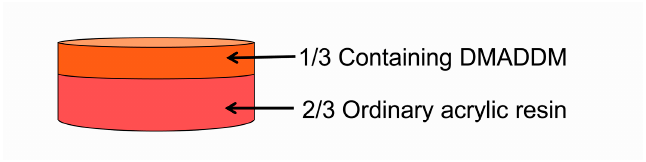
Figure 1. Double-decked acrylic resin containing DMADDM.